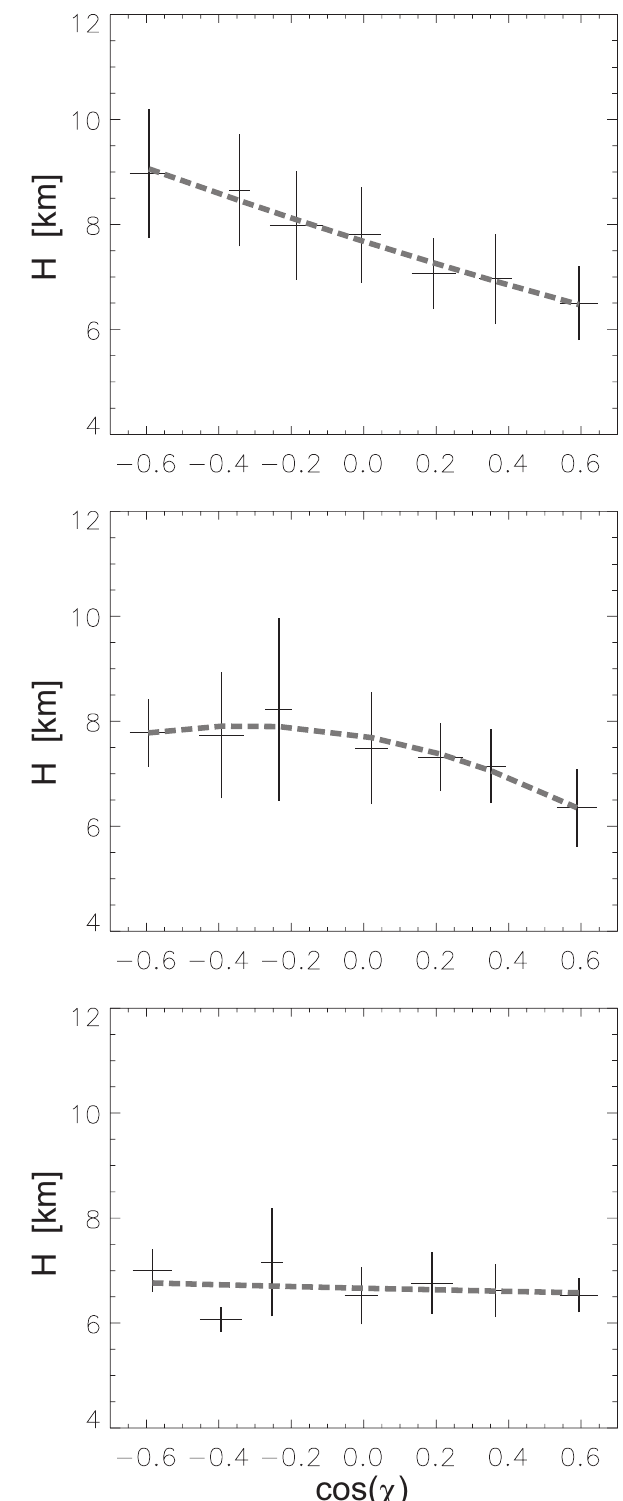
Fig. 5. Dependence of the scale height H on solar zenith angle (cos χ ) and geomagnetic condition. Upper panel: K = 0, 1, middle panel: K = 3, lower panel: K = 6, 7,